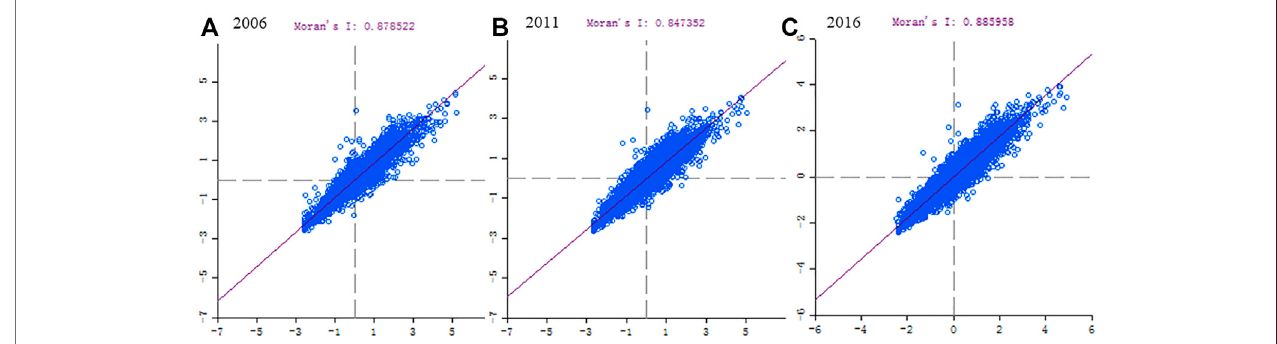
FIGURE5| ScatterplotofGlobalMoran ’ sindexderivedfromJinan ’ slandecologicalsecurityindifferentyears. (A – C) representtheresultsin2006,2011and2016.